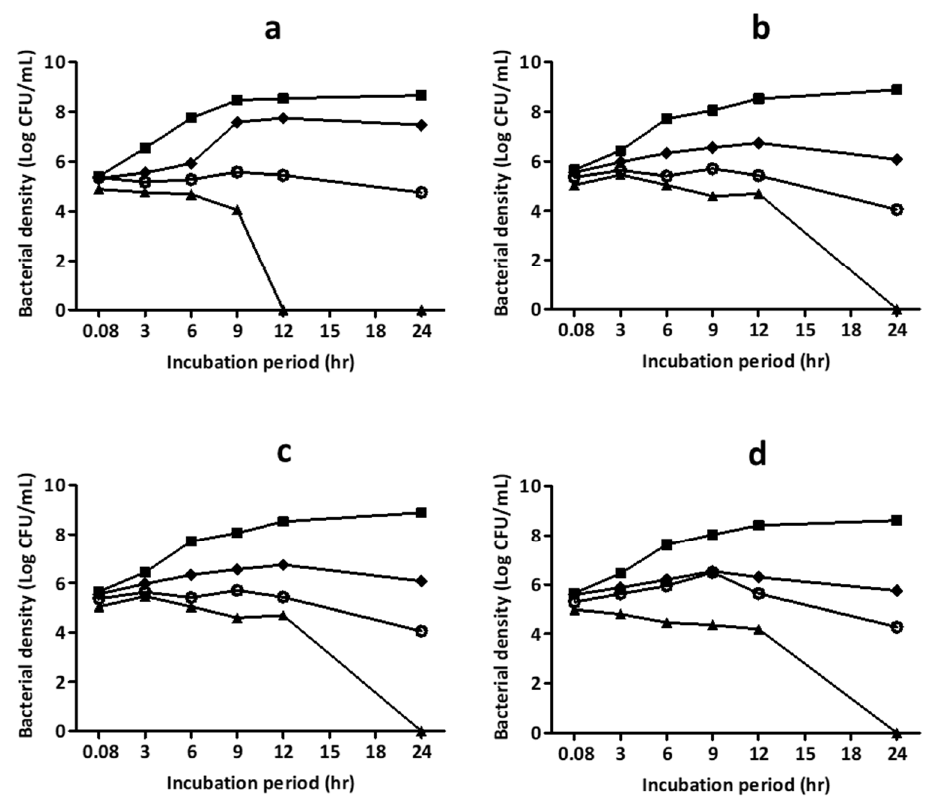
Figure 3. Time-kill curves of the hot water infusions of ( a ) licorice root, ( b ) barberry root, ( c ) oregano flowering shoots, and ( d ) thyme flowering shoots on the growth of Streptococcus pyogenes ATCC 19615. A viable count was performed for different folds of their respective minimum inhibitory concentrations (MICs) at 0.08, 3, 6, 9, 12, and 24 h incubation time points. = 2 × MIC; = MIC; = ½ × MIC; (cid:35) = BHI media (diluent) control. Each data point represents mean from three independent experiments performed in triplicate.